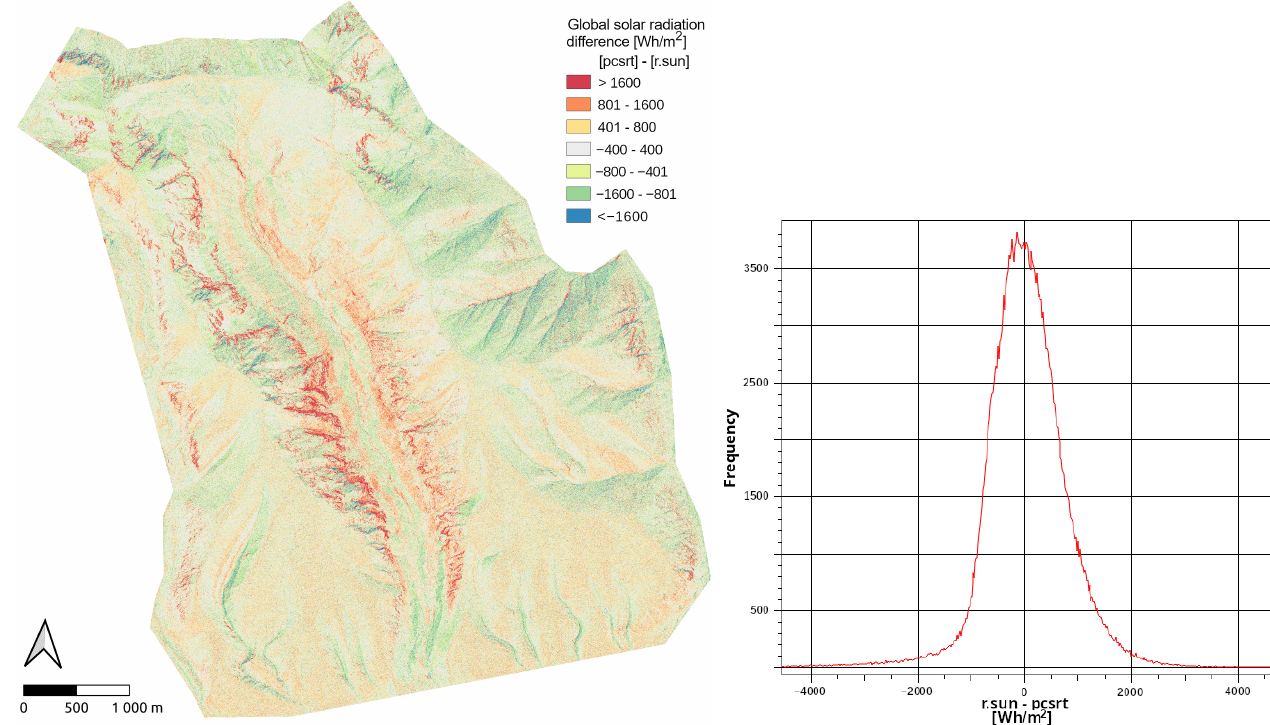
Figure 9. Differences in the daily-cumulative global solar radiation for 21 June 2022 between the r.sun and pcsrt models in the Kamenistá valley